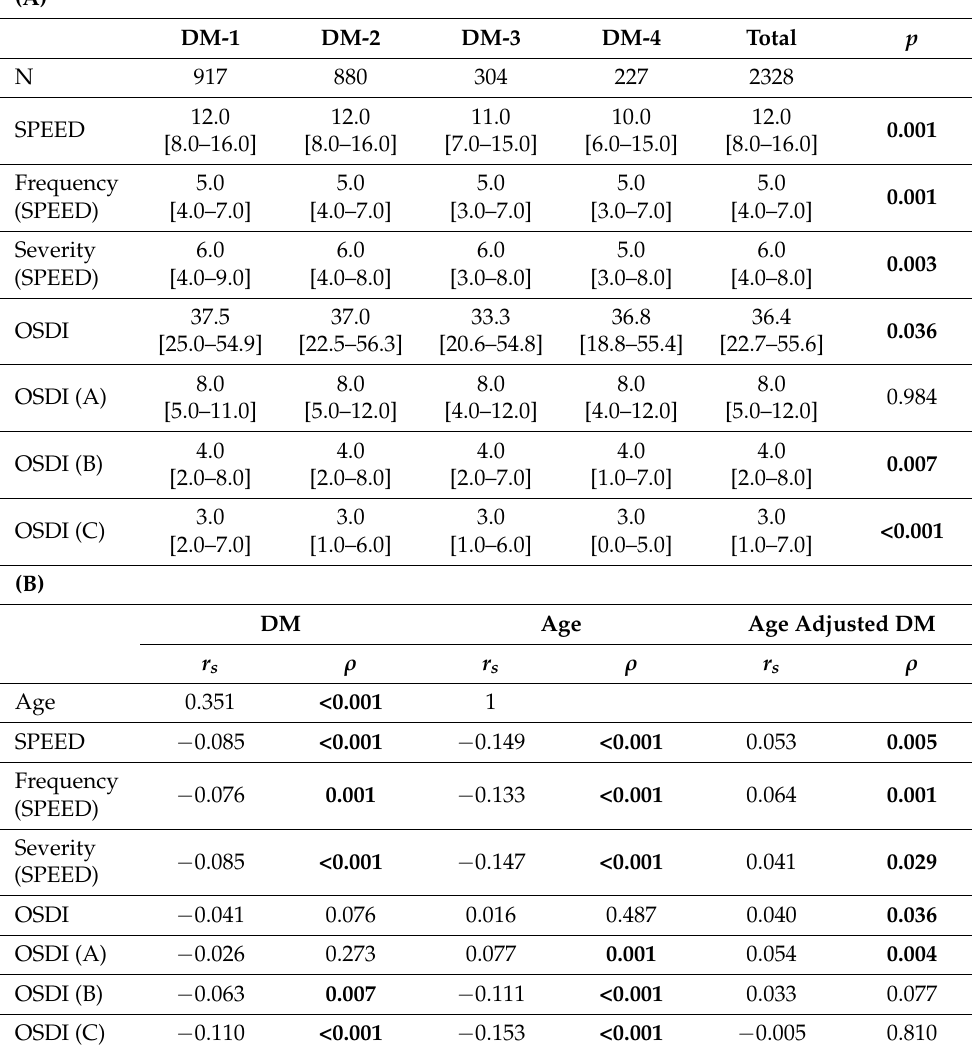
Table 2. Summary and correlation of subjective symptoms (A).Summary of subjective symptoms according to dermatochalasis severity. (B) Correlations among dermatochalasis severity, age, and subjective symptom